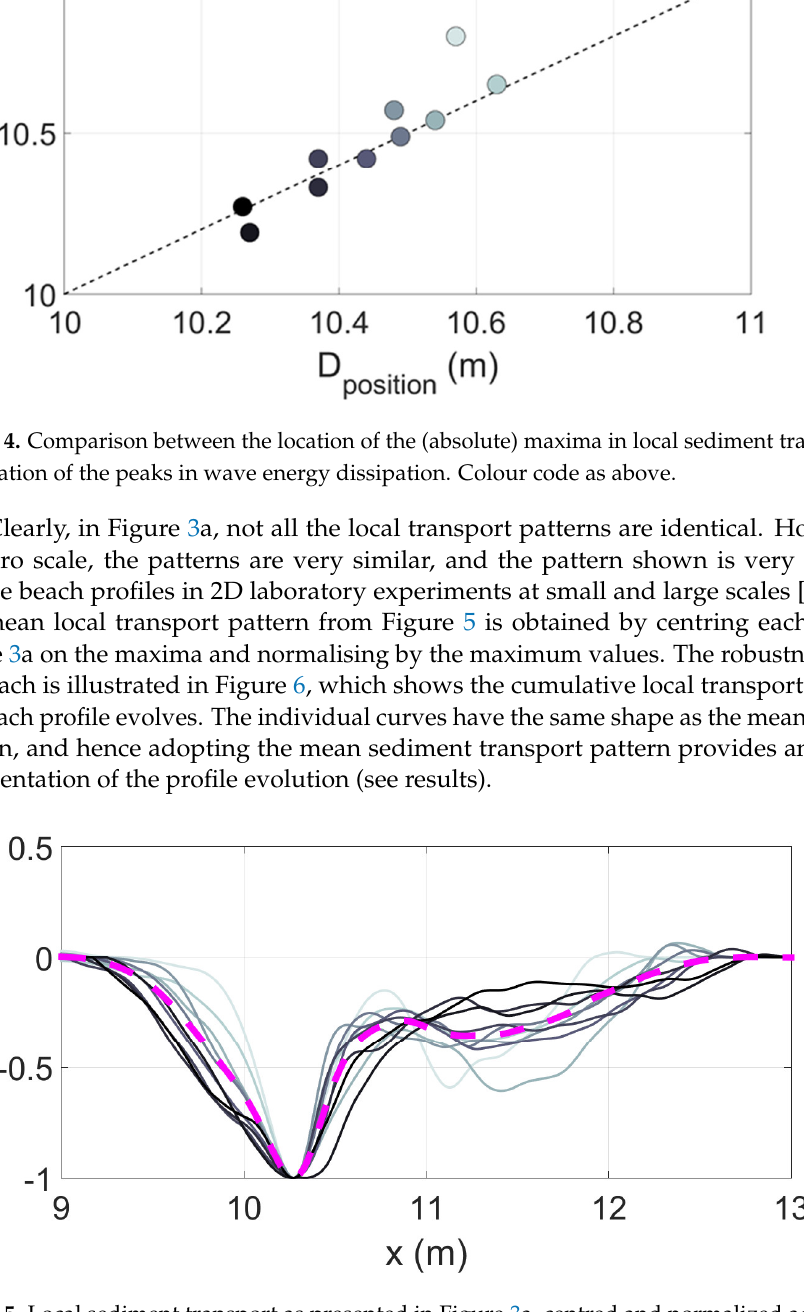
Figure 6. Cumulative local sediment transport rate for the erosive waves conditions from the ini- tial beach state, in chronological order from light grey (start) to dark grey (finish). Note that while the cumulative transport patterns are less ‘noisy’, normalising and using the mean of the cumulative transport rates leads to a shift in the maximum transport away from the location of the peak in the dissipation. This is because the cumulative rate contains a lag effect from the preceding history of the beach evolution. Therefore, the local transport is averaged to determine the mean transport pattern. The mean and local sediment transport patterns are also similar to those observed in the field, see Patterson [15], his Figure 5.8, where the maxima in sediment transport also occurs in the vicinity of the wave break point. Here, the model is illustrated using labora- tory data. For a given beach in the field, we expect that the transport patterns do not vary significantly, since beach profiles cycle between different beach states, but may well vary for different beaches. This remains to be investigated, but the same model concepts can be applied with either bespoke or a generic local transport pattern. The mean normalised local transport pattern in Figure 5 corresponds to a typical ero- sive shape. It is used as the standard transport shape for the erosive model in the present paper. The same pattern is easily scaled for a different wave condition by normalising the profile extent using the run-up limit and the depth of closure. The magnitude of the sedi- ment transport rate is obtained by from the Q- Ω model developed equation (1) developed by Birrien et al. [8]. That model is analogous to the shoreline models of Yates et al. [2] and Splinter et al. [6], but estimates the bulk transport rate, rather than the shoreline position.